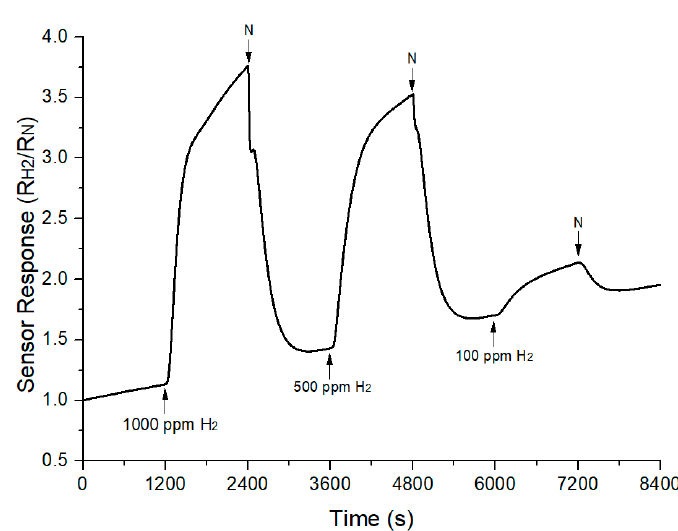
Figure 12. Sensor response of TiO 2 -B 2 O 3 gas sensor to hydrogen at 300 °C.